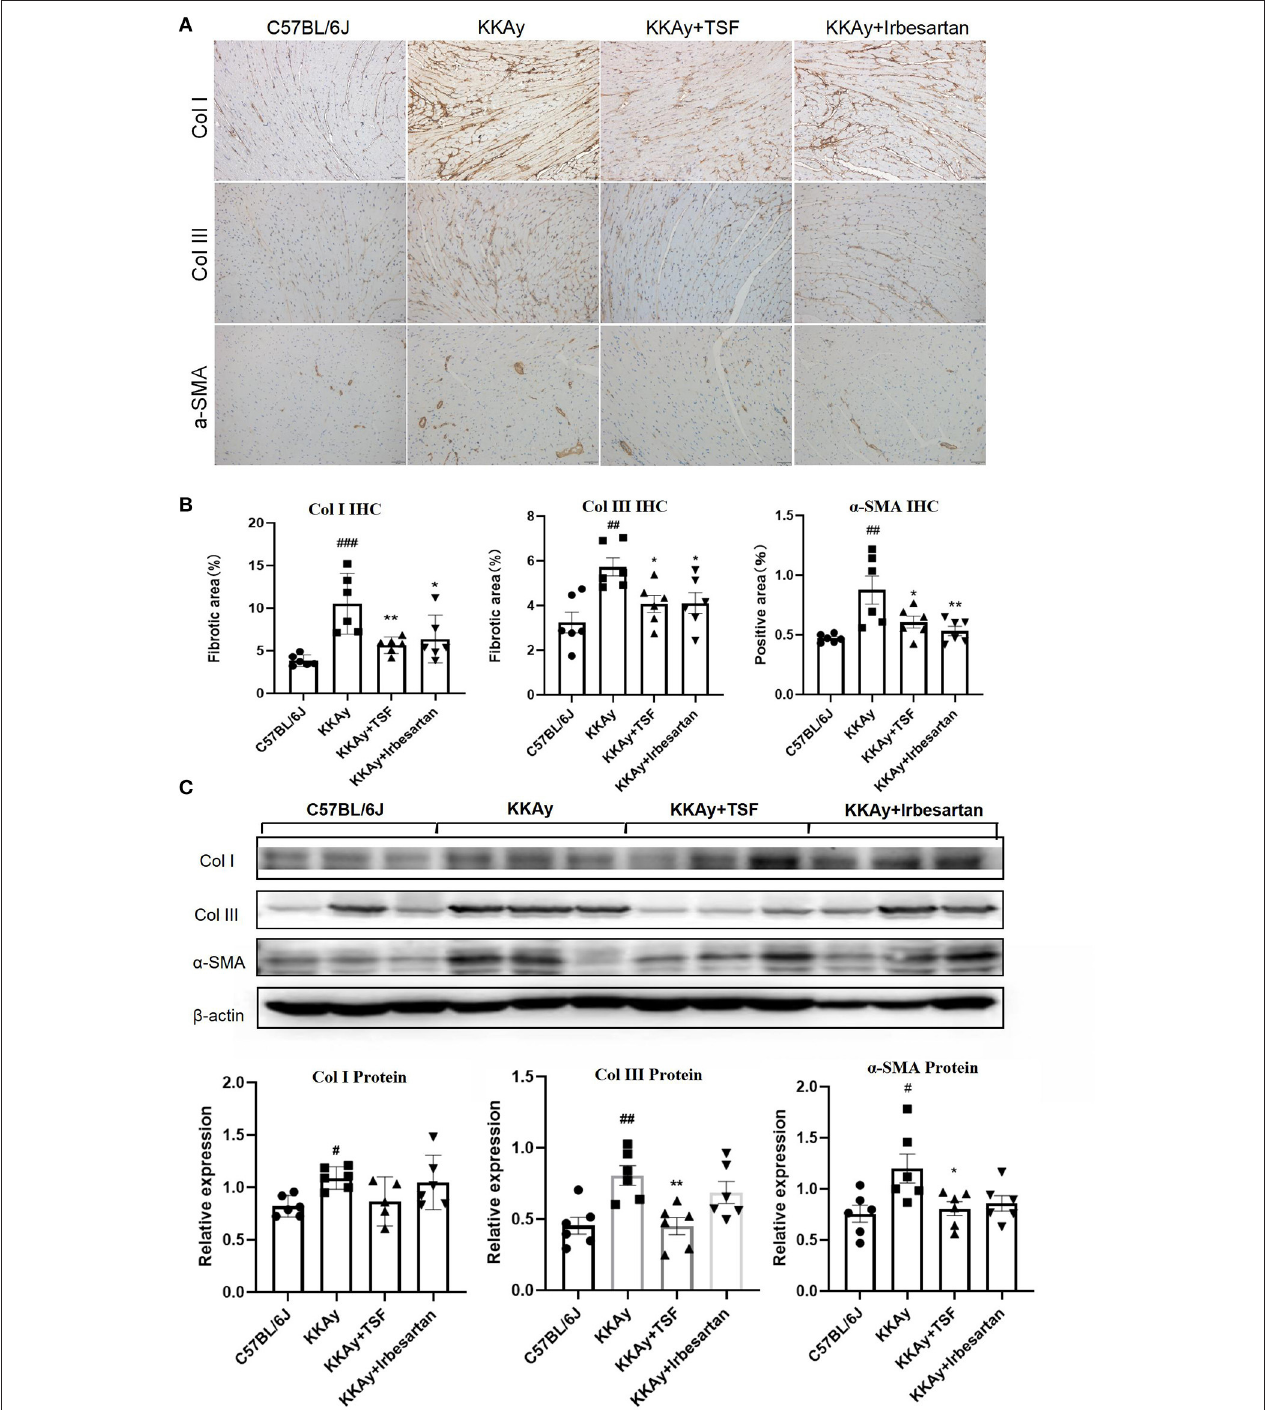
FIGURE 2 | Tangshen Formula inhibited myocardial fibrosis in KKAy mice. (A) Immunohistochemistry (IHC) of collagen III (ColIII, original magnification, 200 × ), collagen I (ColI, original magnification, 200 × ), and alpha smooth muscle actin ( α -SMA, original magnification, 200 × ). (B) IHC and semi-quantitative analyses for collagens I and III, and α -SMA. Data are expressed as mean ± SEM ( n = 6). * p < 0.05, ** p < 0.01 TSF-treated group vs. KKAy group; # p < 0.05, ## p < 0.01, ### p < 0.001 KKAy group vs. C57BL/6J group. (C) Western blot and semi-quantitative analyses of ColI, ColIII, and α -SMA expressions.